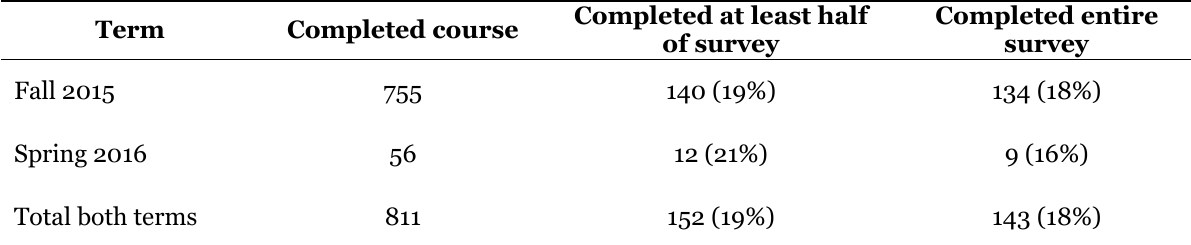
Completed at least half Completed entire of survey survey